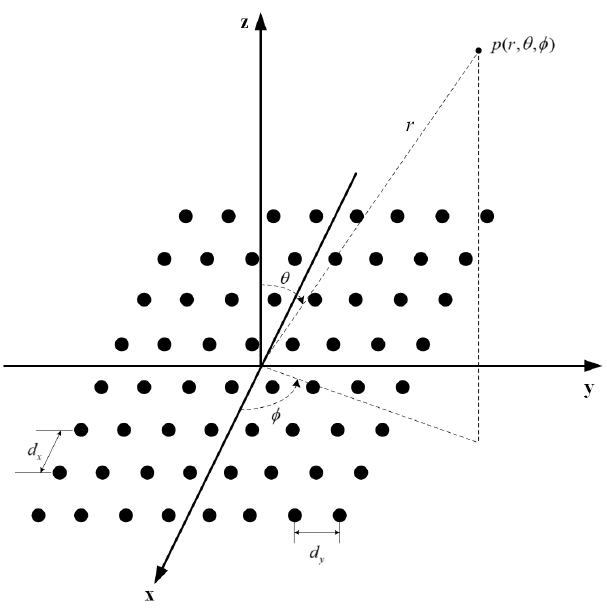
Figure 5. The planar phased array